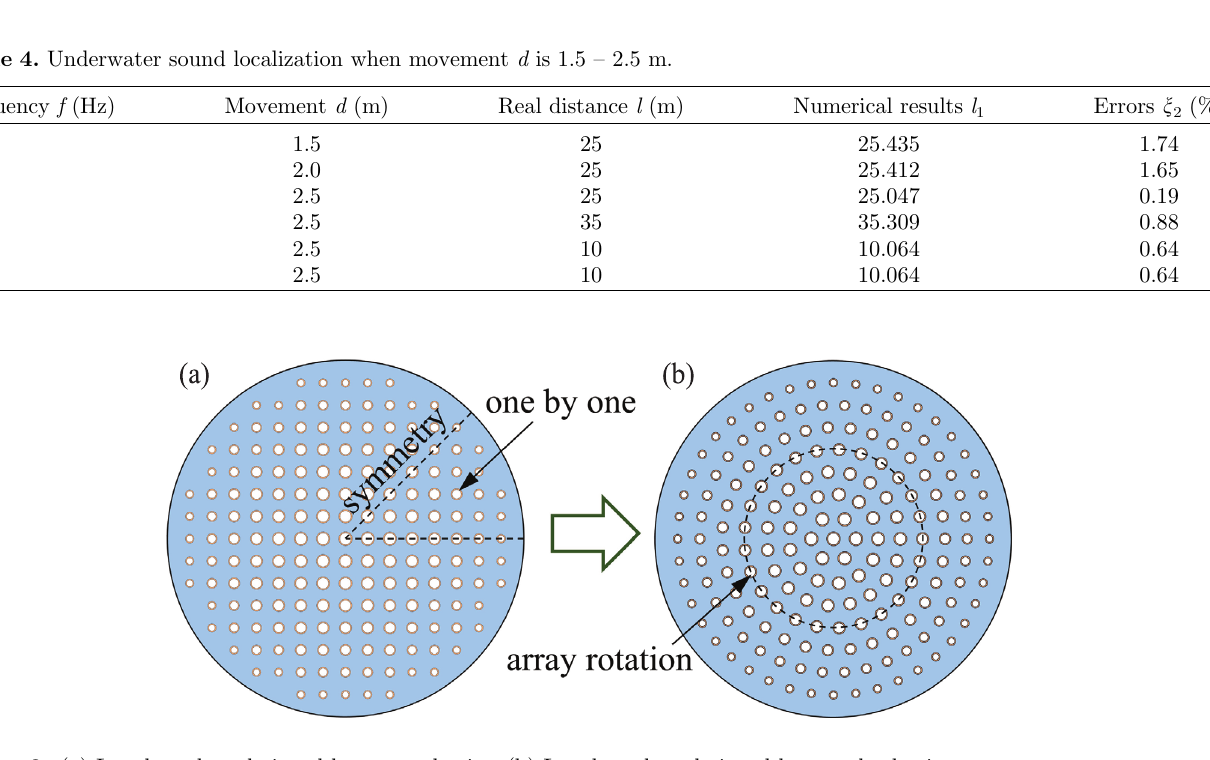
Figure 8. (a) Luneburg lens designed by square lattice. (b) Luneburg lens designed by annular lattice.